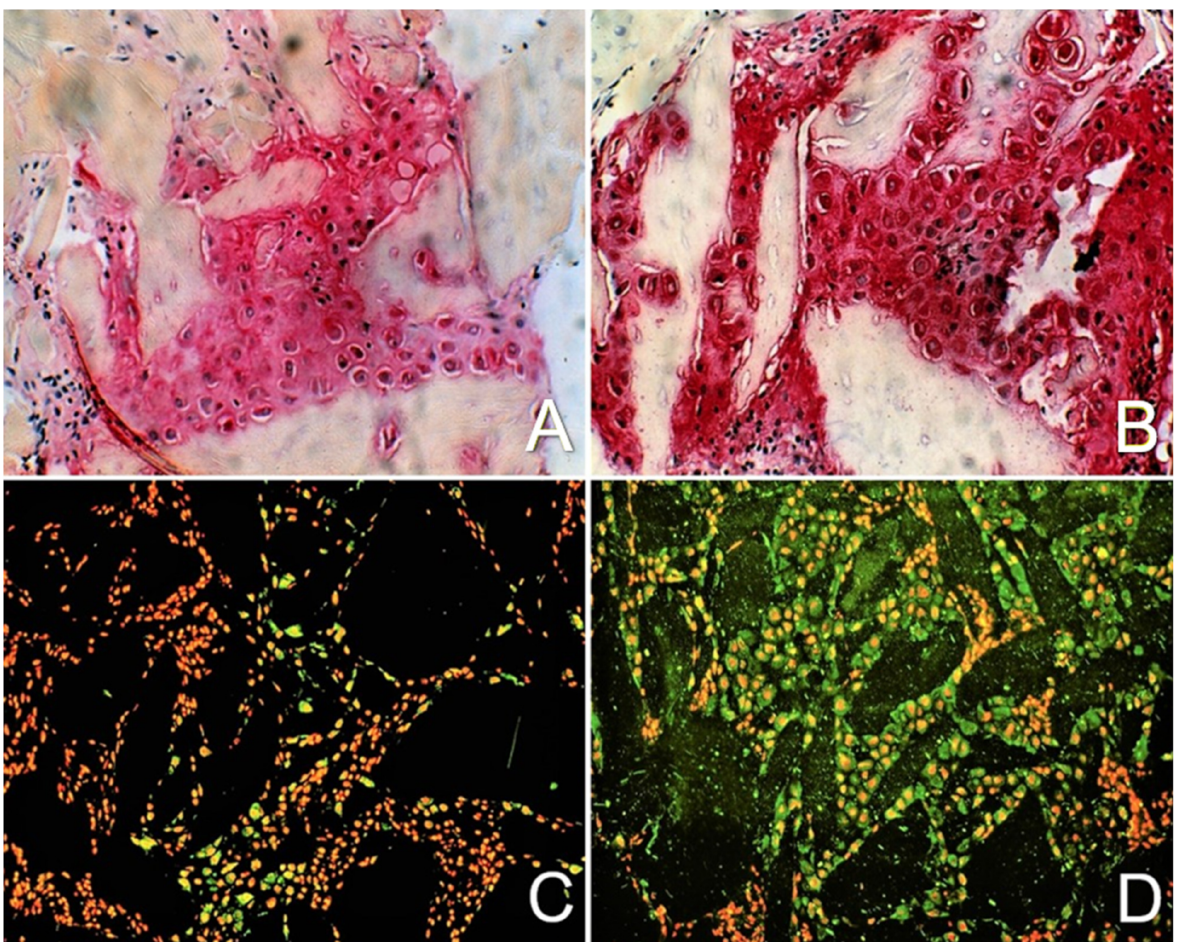
Figure 6. ECM molecules with exposure to PEMFs. ( A ) Trichrome Safranin O histochemistry of unexposed control ossicles. Gray homogeneous areas are DBM particles (40 × ). ( B ) Histochemistry showing increased ECM deposition of aggrecan (dark Safranin O red staining) in ossicles exposed to PEMFs (40 × ). ( C ) Immunohistochemistry of unexposed ossicles. Propidium iodide stains the nuclei red. Black areas are DBM particles (20 × ). ( D ) Immunohistochemistry showing increased ECM deposition of collagen II (green) in PEMF-exposed ossicles (20 × ). Adapted with permission from Ref. [9]. 2002, Journal of Orthopaedic Research